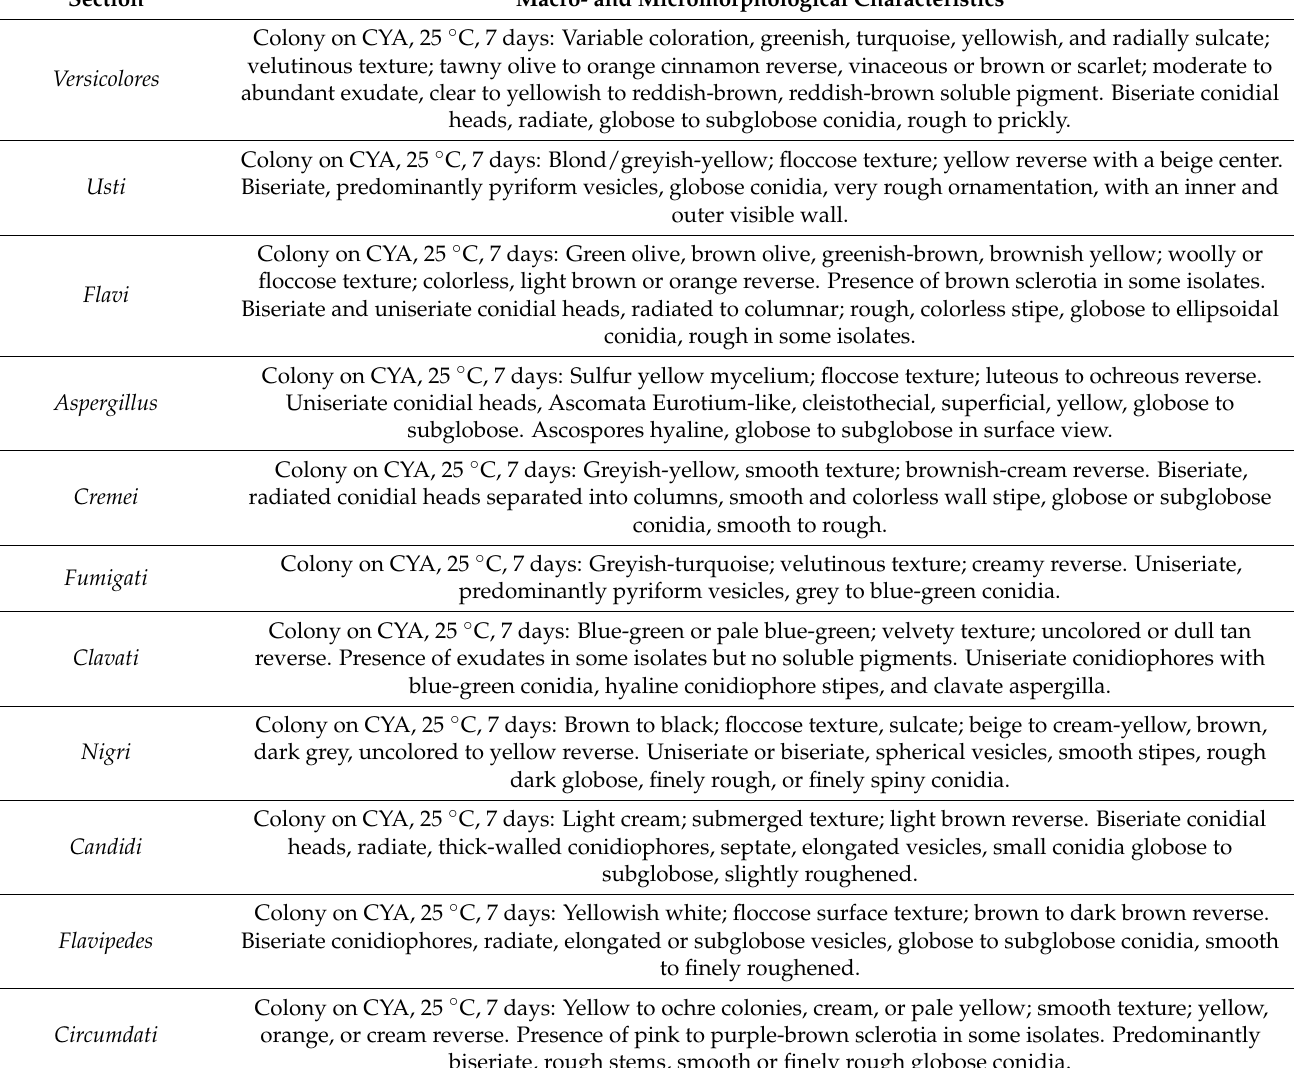
Table 2. Distinctive macro and micromorphological features of the studied Aspergillus isolates. Section Macro- and Micromorphological Characteristics